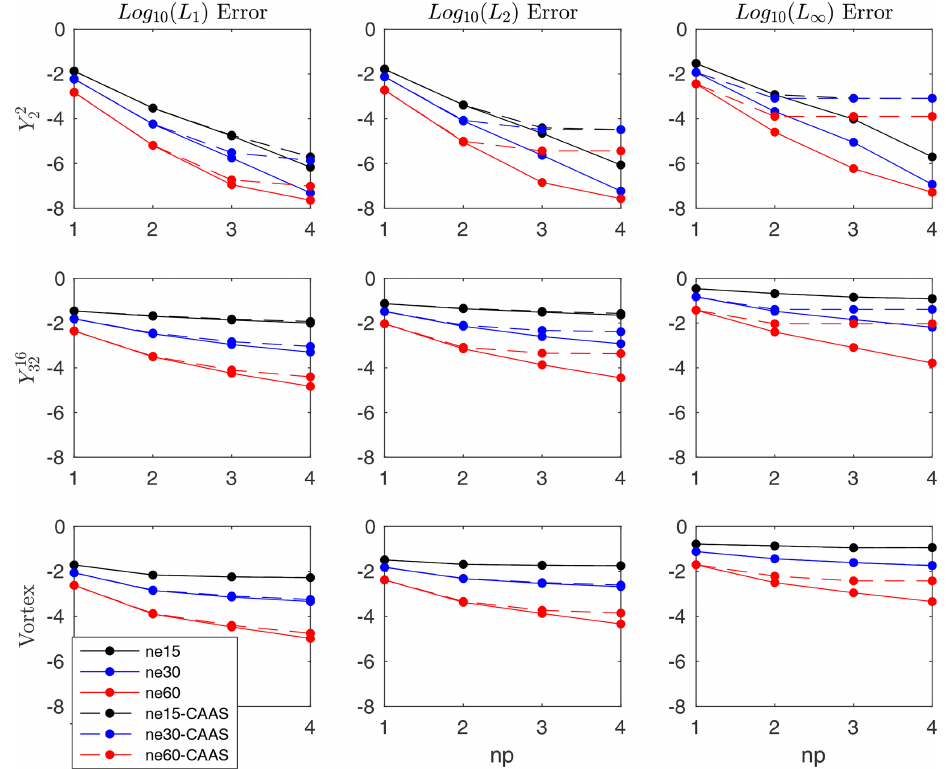
Figure 1. Convergence test for finite-volume to finite-volume remapping from cubed spheres to a 1 ◦ latitude–longitude mesh for three different test cases. The dashed lines show the results using CAAS with local- p bounds preservation, and the solid lines are the results without